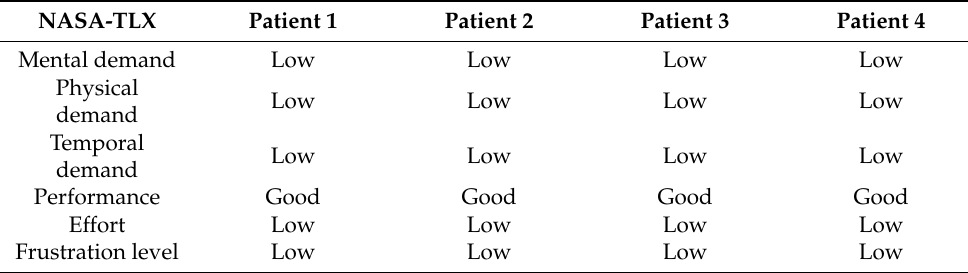
Table 4. National Aeronautics and Space Administration task load index